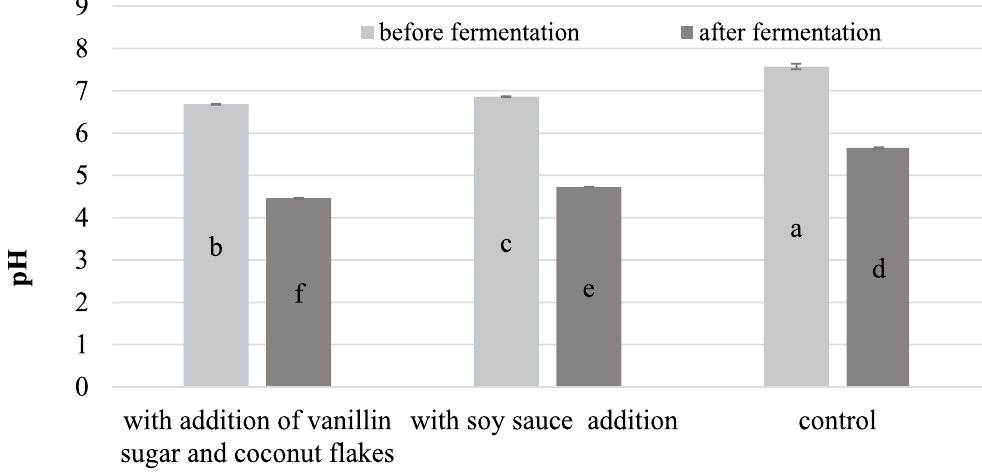
Fig. 3. Comparison of the changes in pH values in the chickpea beverages after the fermentation process. Explanatory notes: Mean values ± mean standard deviation (x ±s/SD; n = 3) with different letters indicate statistically significant difference (P<